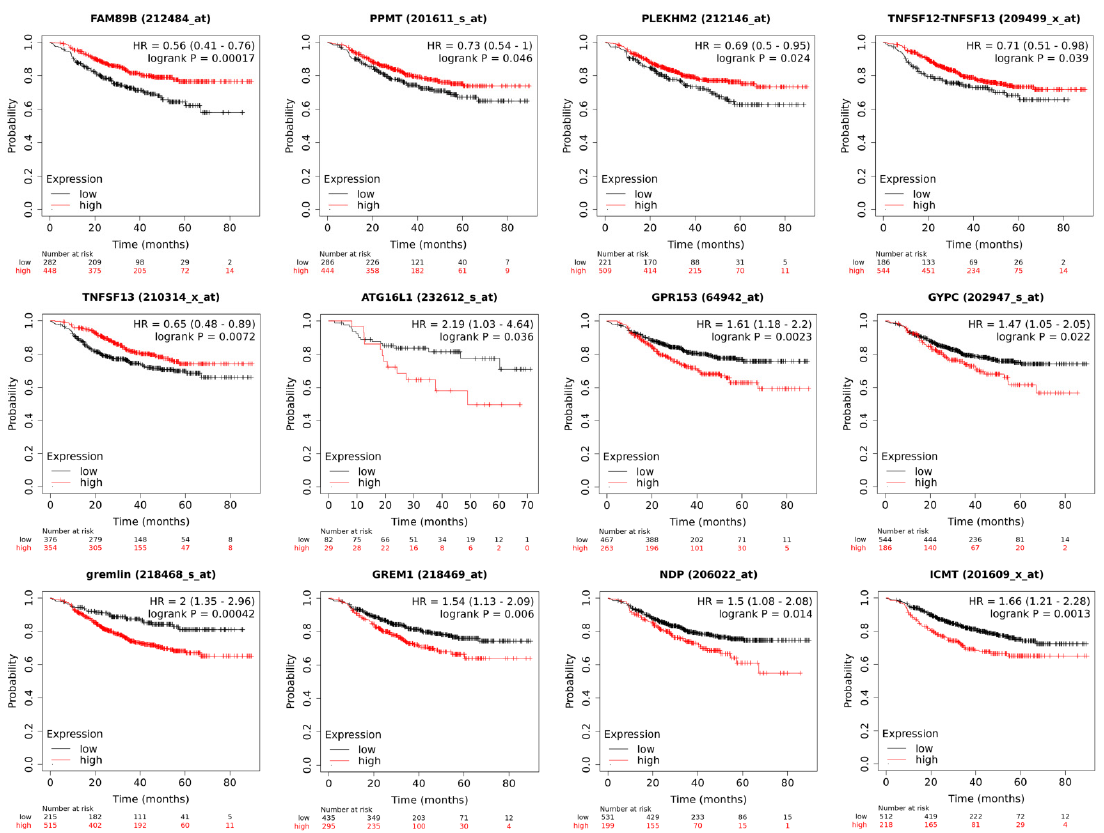
Figure 4. Non-metastatic survival of patients with breast cancer depending on the level of gene expression 232612_s_at ( ATG16L1 ), 212484_at ( FAM89B ), 212146_at ( PLEKHM2 ), 202947_s_at